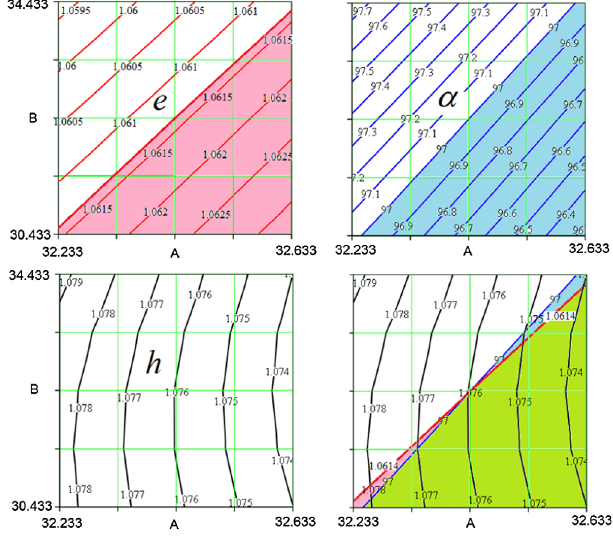
FIG. 10. Map for the original SNS cavity. a ¼ 11 . 565 mm, b ¼ 20 . 818 mm, β ¼ 0 . 81 .